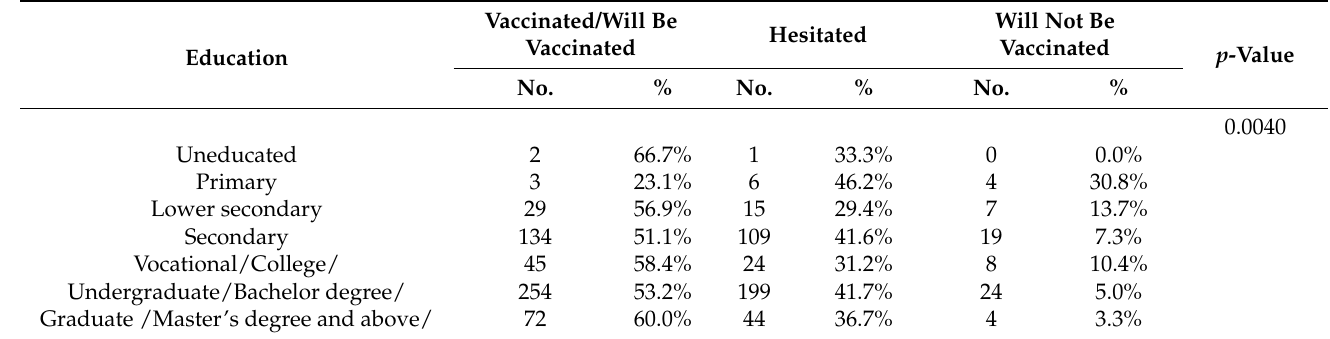
Table 2. Willingness to be vaccinated for COVID-19 by education